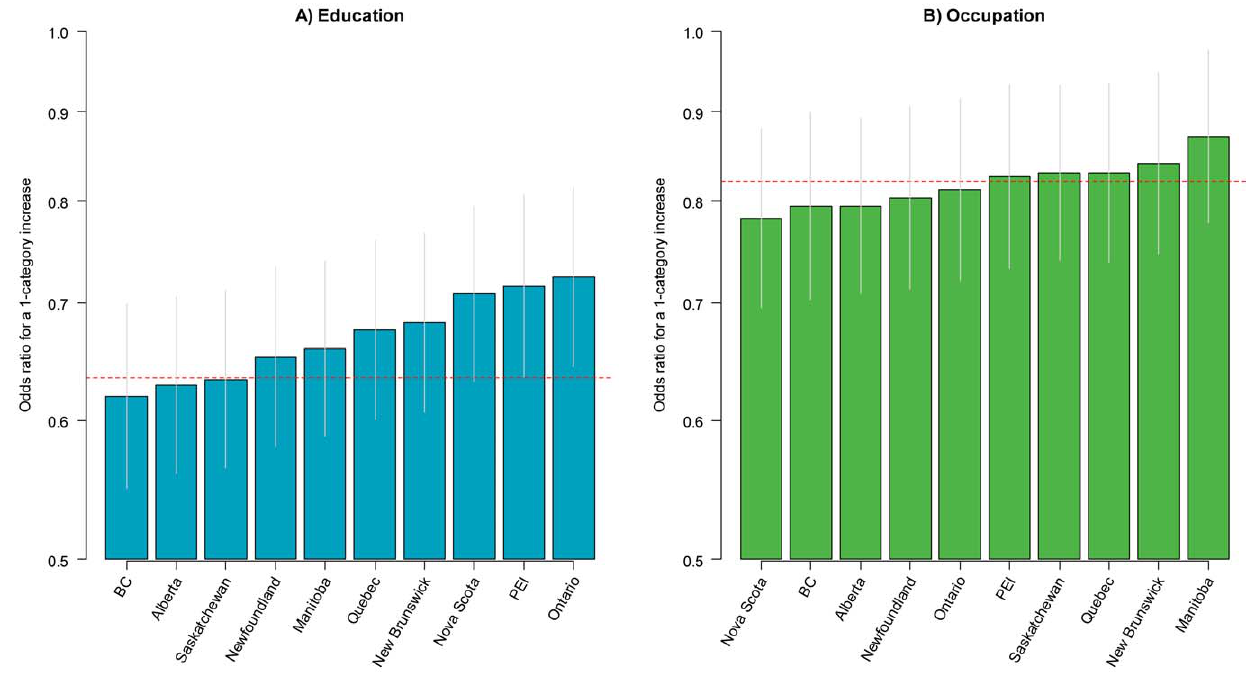
Figure 5. Odds ratios for current smoking for a one-category increase in the level of education and occupation across Canadian provinces. BC British Columbia; PEI Prince Edward